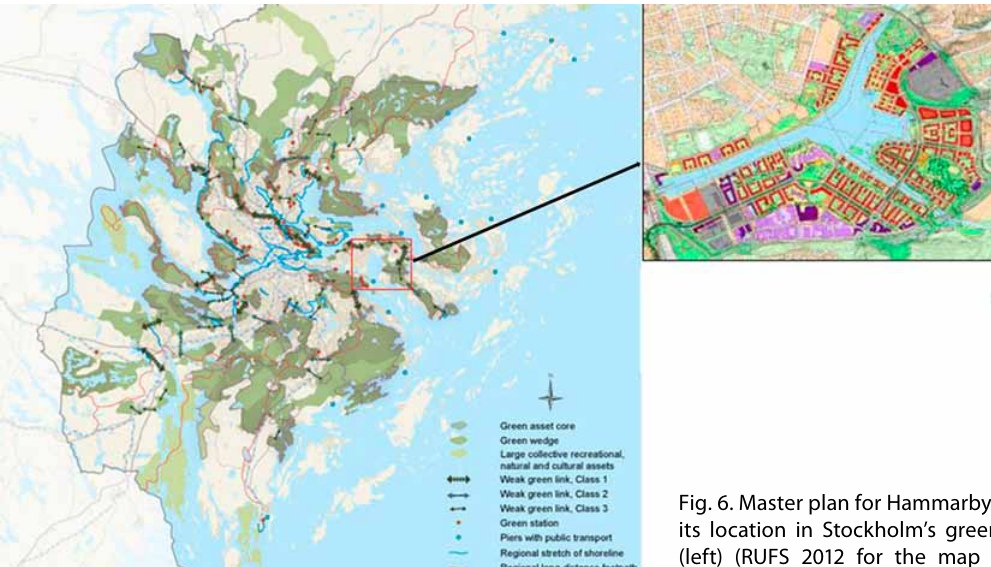
fig. 6. Master plan for Hammarby Sjöstad (right) and its location in Stockholm’s green wedge structure (left) (rufS 2012 for the map on the right, and Hammarbysjöstad Kommun for the left-hand